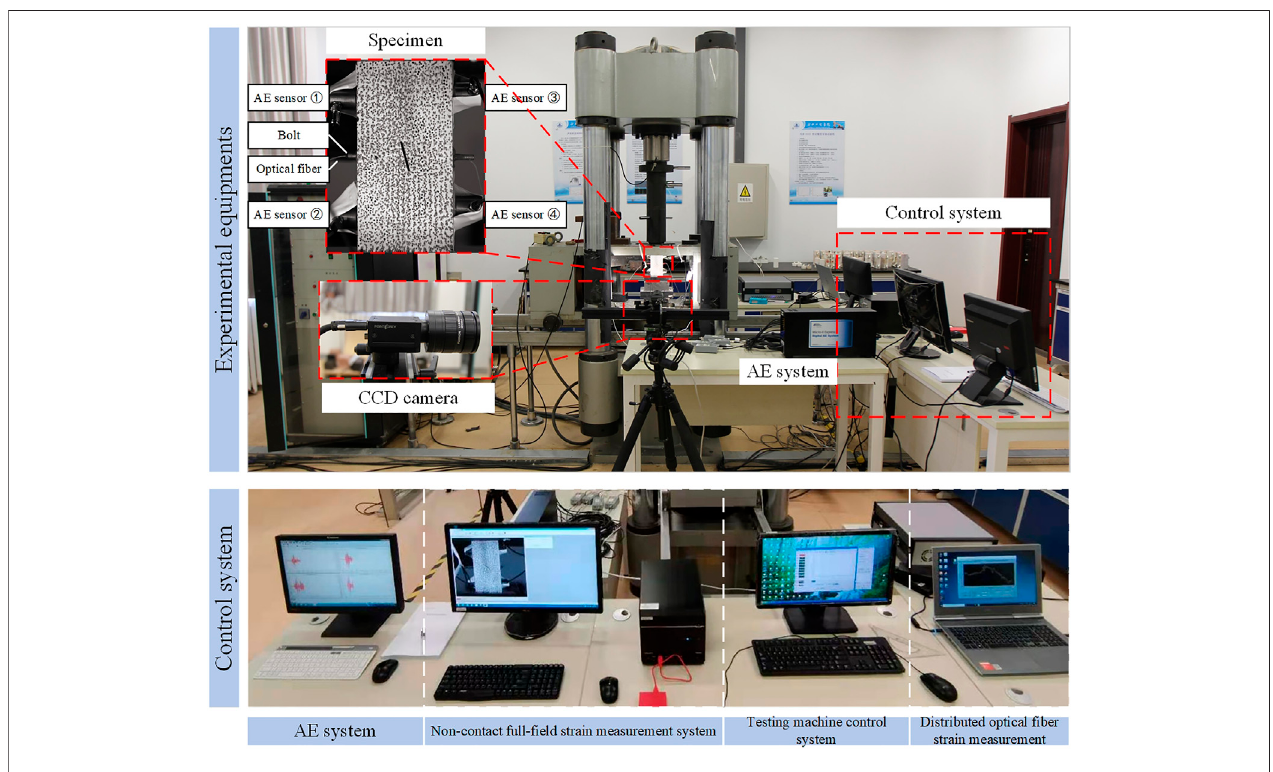
FIGURE 2 | Experimental